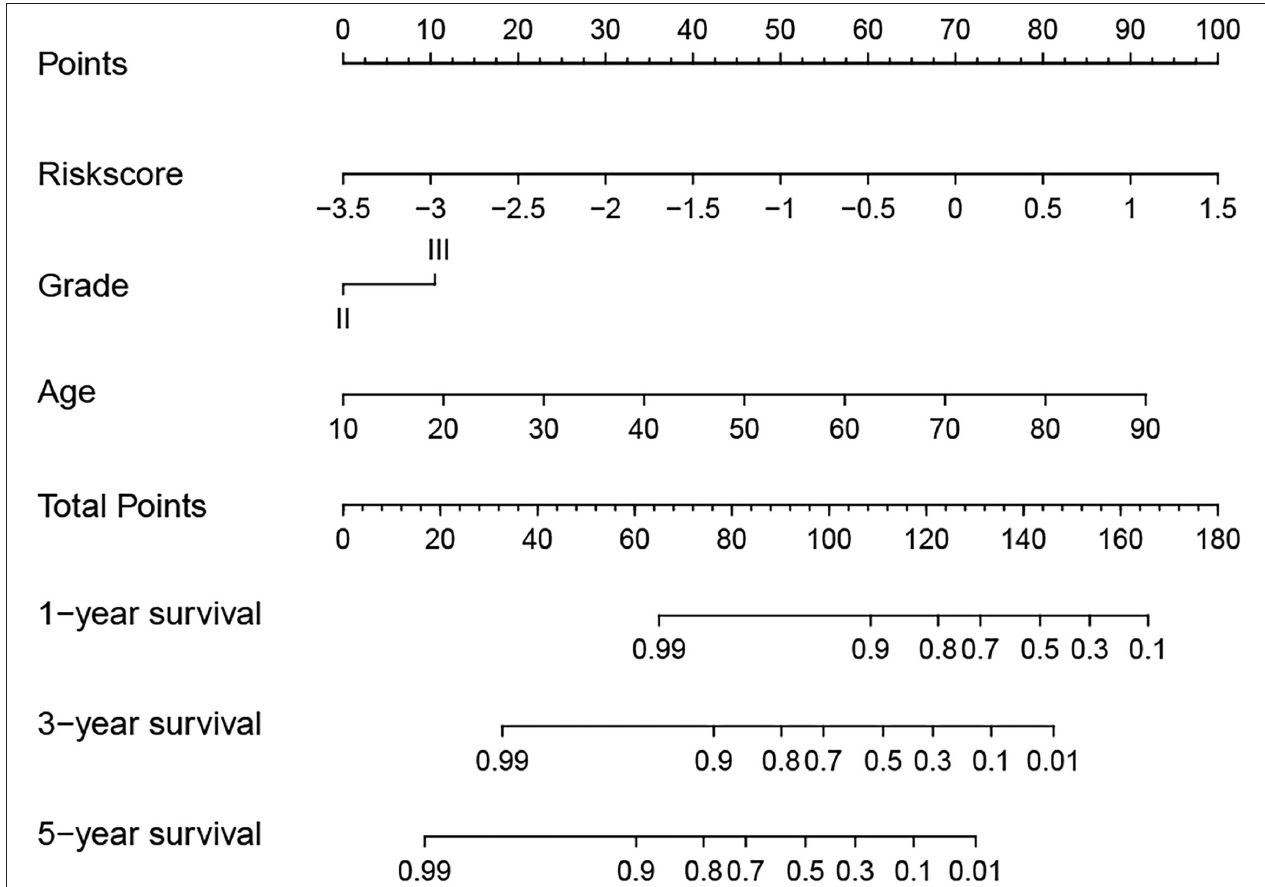
FIGURE 6 | A nomogram model was established to predict the overall survival (OS) of lower-grade glioma (LGG) in The Cancer Genome Atlas (TCGA) training cohort.